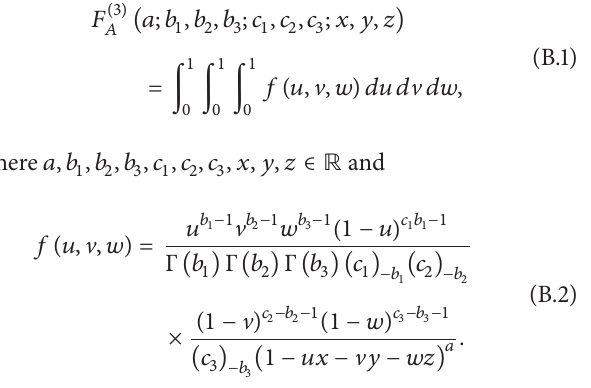
Figure 3: Average symbol error probability, 𝑃 hop DF relaying with RS as a function of the average symbol to noise power, 𝐸 𝑠 /𝑁 0 , for 𝐿 = 3 relays and various Nakagami- 𝑚 fading